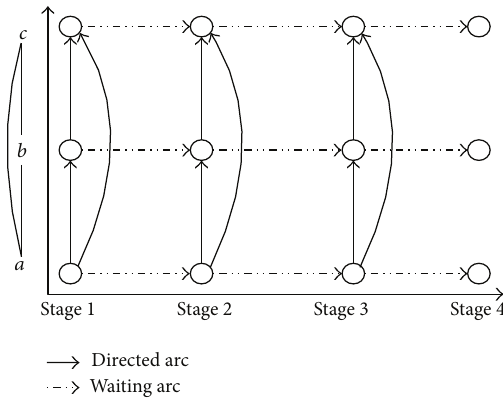
Figure 3: An illustration of a space-time